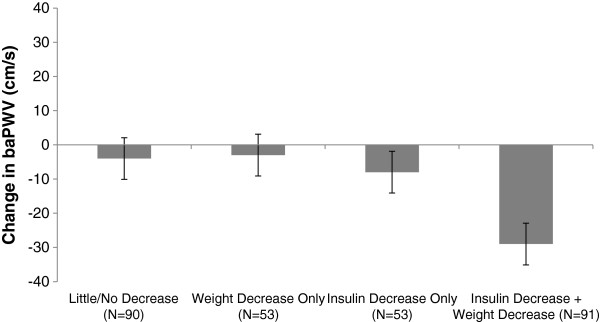
Adjusted* mean changes in baPWV by insulin- and weight-loss groups in the SAVE trial. Baseline and 6-month mean PWV measures are plotted by weight and insulin-loss groups where groups are split by median changes in weight and fasting insulin levels. *Adjusted for age, sex, race, smoking status and baseline BMI, mean arterial pressure, HDLc, triglycerides, CRP, fasting insulin, baPWV and change in mean arterial pressure. baPWV: brachial-ankle pulse-wave velocity.